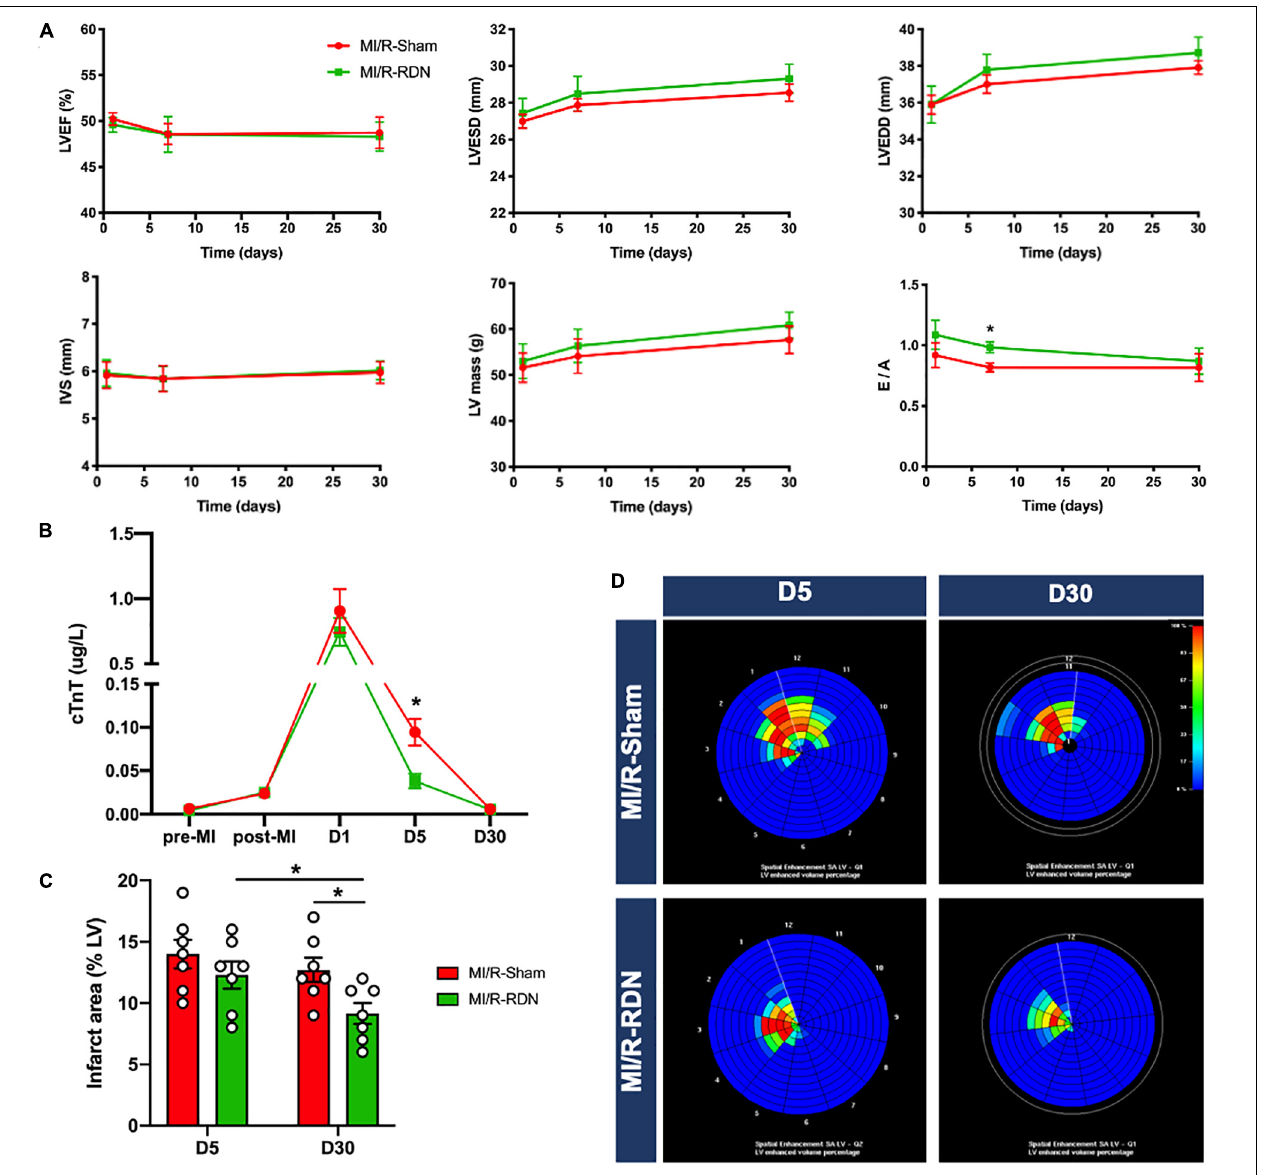
FIGURE 4 | Echocardiography and CMR outcomes. (A) The parameters of echocardiography, left ventricular ejection fraction (LVEF), interventricular septal thickness (IVS), LV mass, and the ratio of early transmittal flow velocity to late transmittal flow velocity (E/A) were measured with TTE ( n = 7 each group). (B) Serum cardiac troponin T (cTnT) was measured pre-AMI, post-AMI, and 1, 5, and 30 days post-RDN ( n = 7 each group). (C) Analysis of the percentage of the enhanced volume ( n = 7 each group). (D) Representative graphs of the percentage of the enhanced volume assessed using CMR. Data are shown as the mean ± SEM (A–C) . p -Values were shown and assessed by two-way ANOVA with Bonferroni test (A–C) . * p < 0.05 (compared with the MI/R-Sham